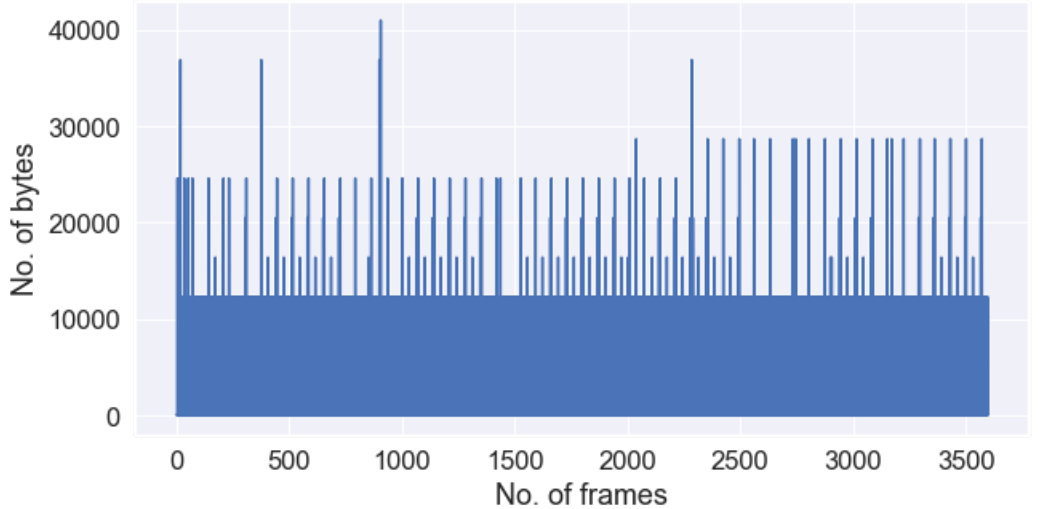
Figure 14a. Disk reads in S2.1.